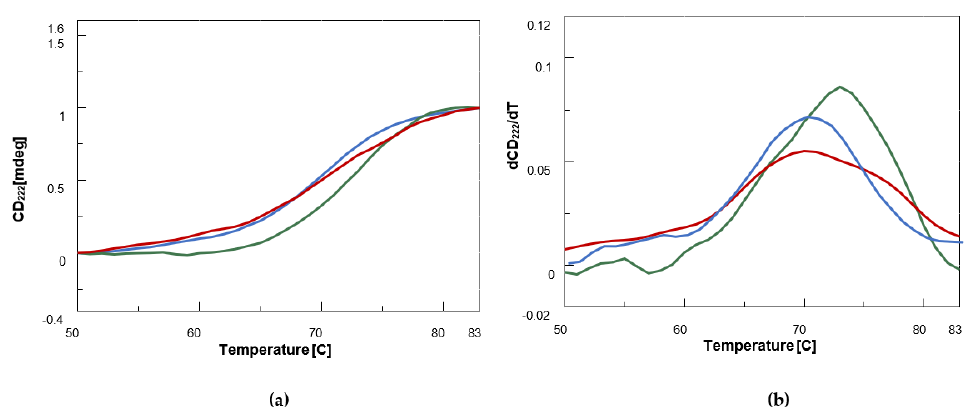
Figure 3. CD thermal denaturation curves [CD 222 (mdeg) vs. T (°C)] ( a ) and first derivatives vs. T ( b ) plots for BSA (0.12 μ M, blue) and its complexes with the benzofuran derivatives (25 nmol) BF1 (green) and BDF1 (red) in 90 mM NaCl, 1.8 mM KCl, 6.6 mM Na 2 HPO 4 , and 1.2 mM KH 2 PO 4 (pH = 7.5) at 20 °C.